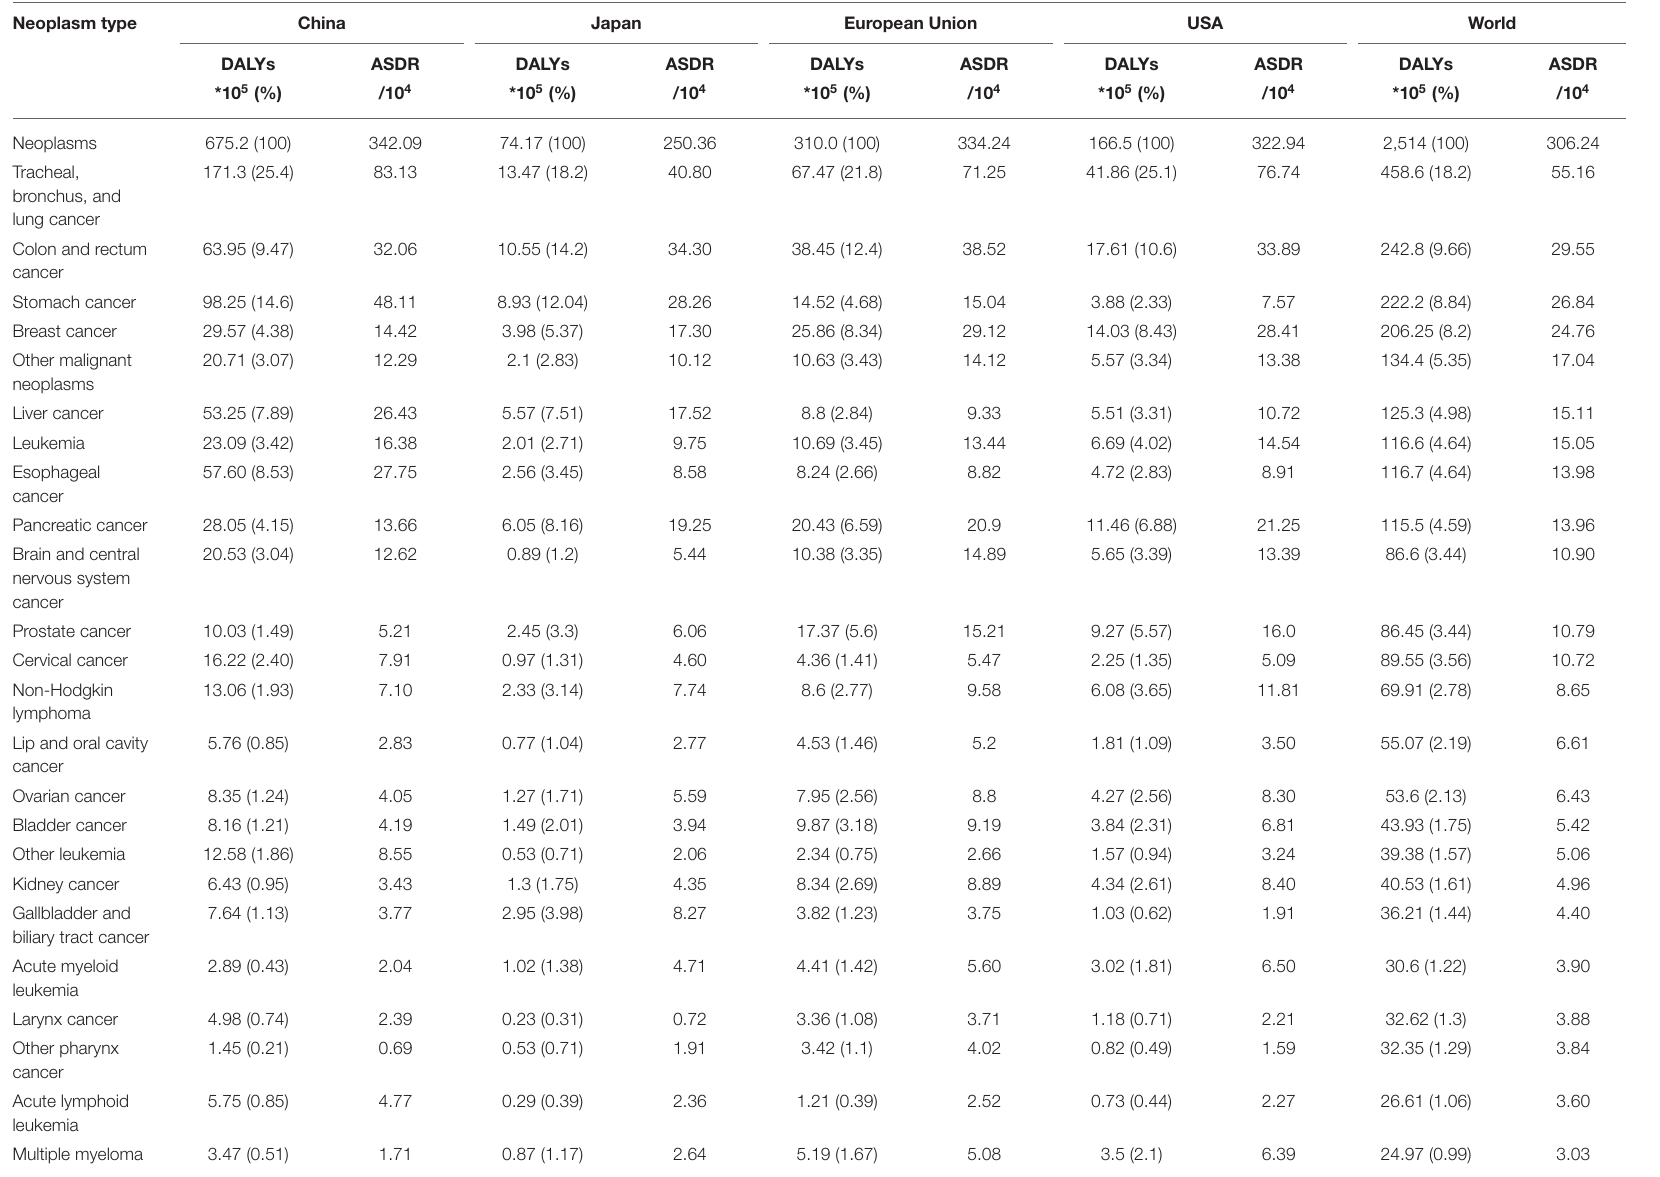
TABLE 1 | The DALYs and age-standardized DALYs rate of all neoplasms in China, Japan, European Union, USA, and the world, 2019, both. Neoplasm